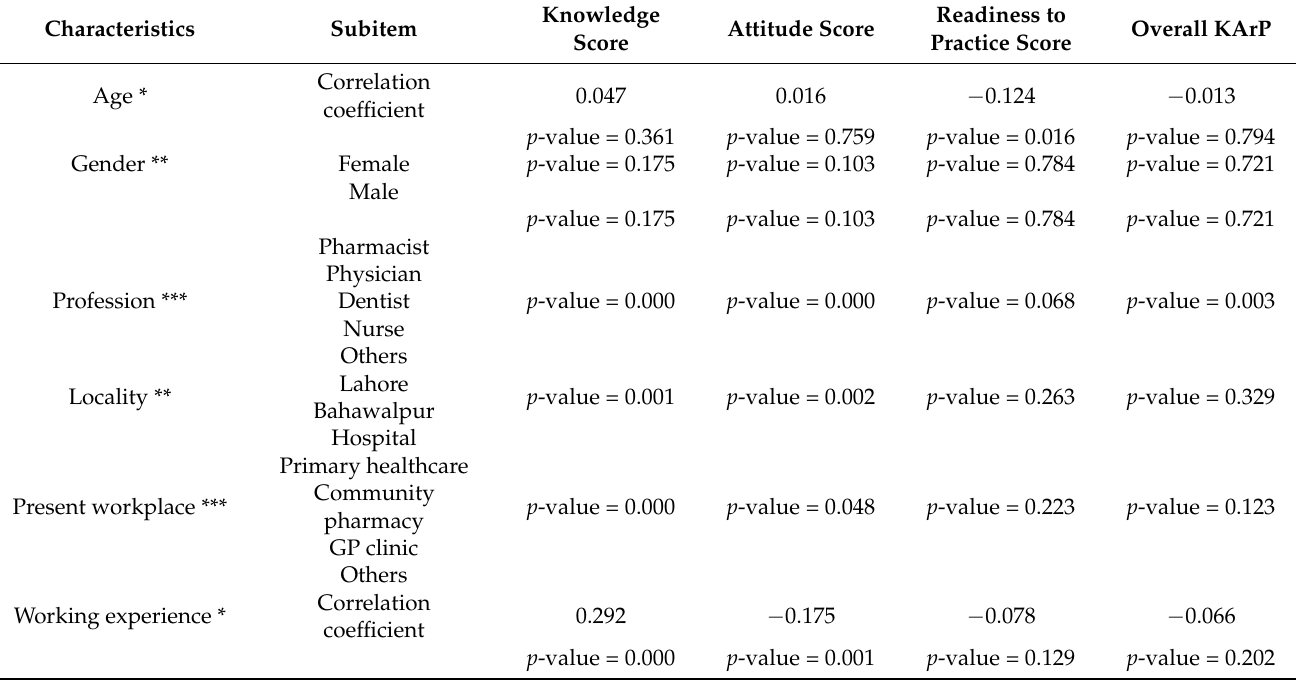
Table 5. Differences of total knowledge, attitude, and readiness to practice scores in terms of demographic characteristics of the respondents.